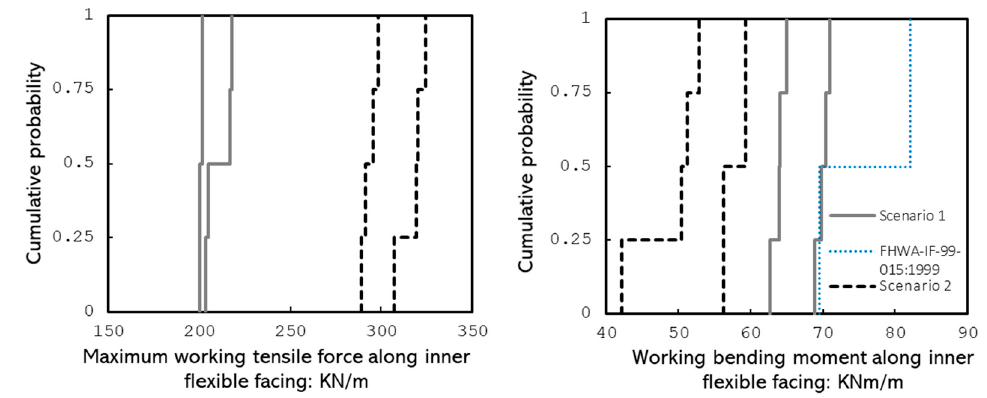
Figure 8. Post-construction deterministic FE predicted mobilised actions on the inner lining: Scenario 1: Stochastically dependent variables: water level and cohesion, scenario 2: Stochastically independent variables: water level and flow rate.